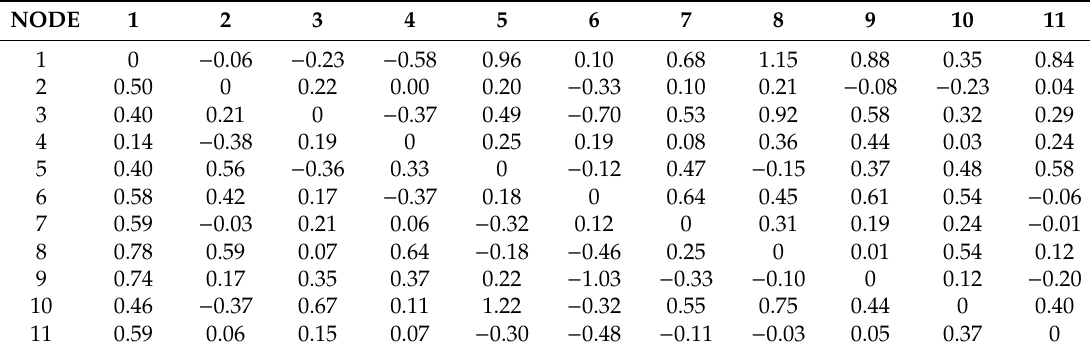
Table A7. Real Madrid’s individual Relative in-Transition